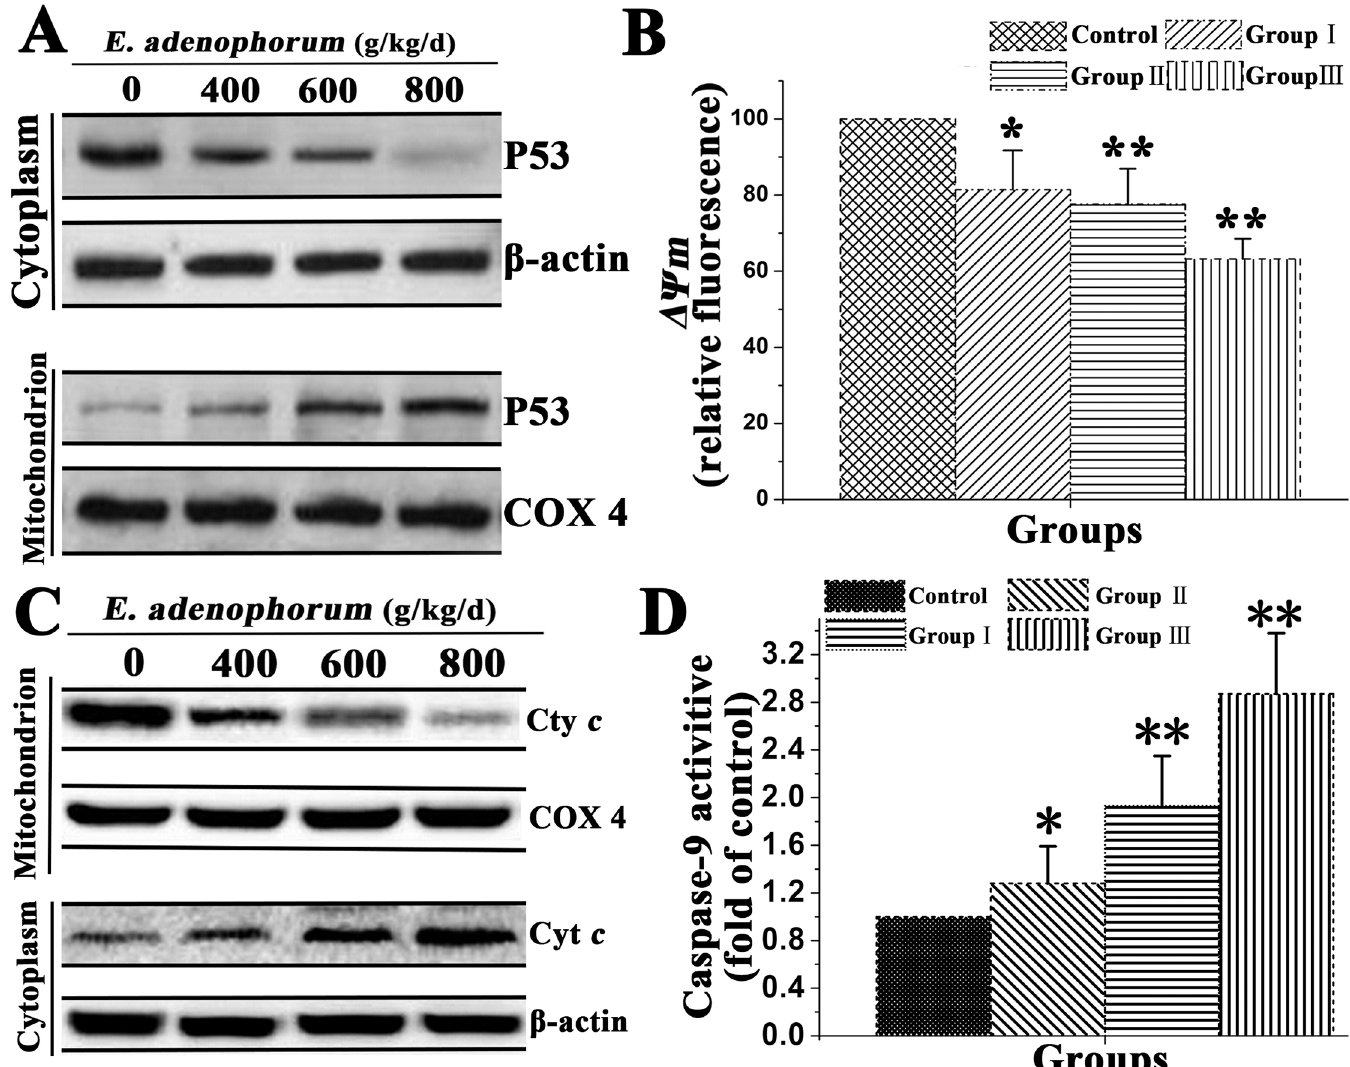
Fig 5. Mitochondrial p53 activates mitochondrial pathway in renal cells. To determine localization of p53, renal cells were incubated as indicated (A) Western blot analyzed the effect of E . adenophorum on p53 mitochondrial translocation. COX 4, mitochondrial loading control. (B) Flow cytometry and JC-1 measure the effet of E . adenophorum on ΔΨ m . (C) Western blot was conducted to analyze the release of Cyt c in renal cells. (D) The effect of E . adenophorum on enzymatic activity of caspase-9 was measured and was expressed relative to the control. Date are presented with the means ± SD and mean values of three independent experiments. * p < 0.05 and ** p < 0.01 compared with the control